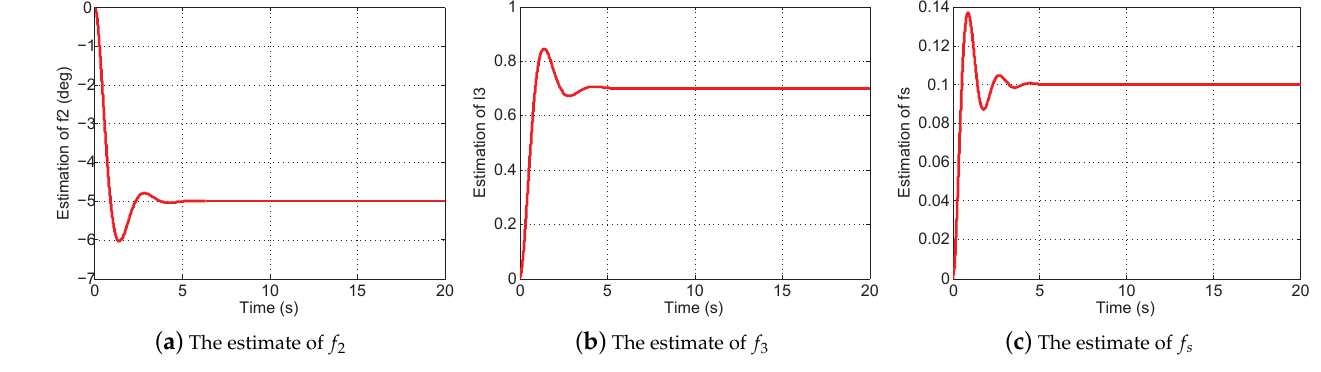
Figure 7. Estimates of fault